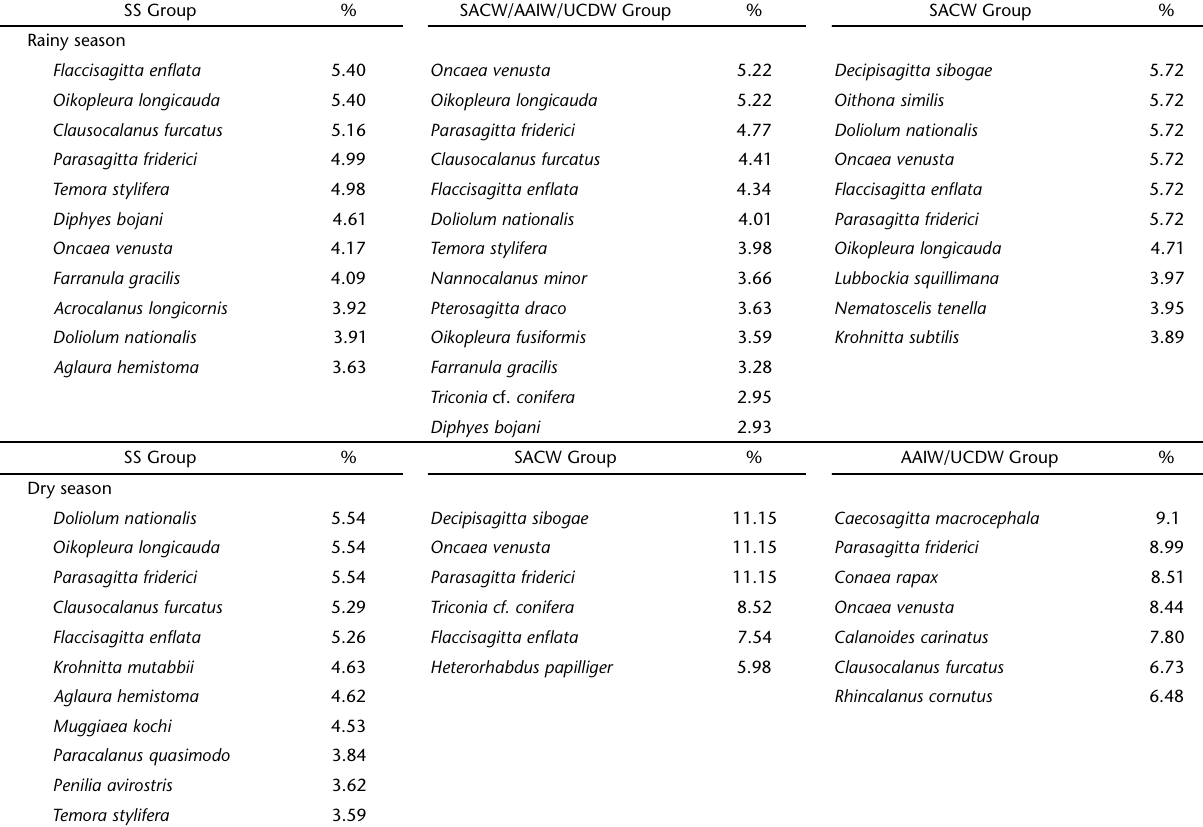
Table III. Mesozooplankton species contributing (up to a total of 50%) to the similarity of faunistic zones during the rainy and dry seasons, over the continental shelf and slope in the Campos Basin, central Brazilian coast (SIMPER). (SS) Subsurface Water, (SACW) South Atlantic Central Water, (AAIW) Antarctic Intermediate Water, (UCDW) Upper Circumpolar Deep